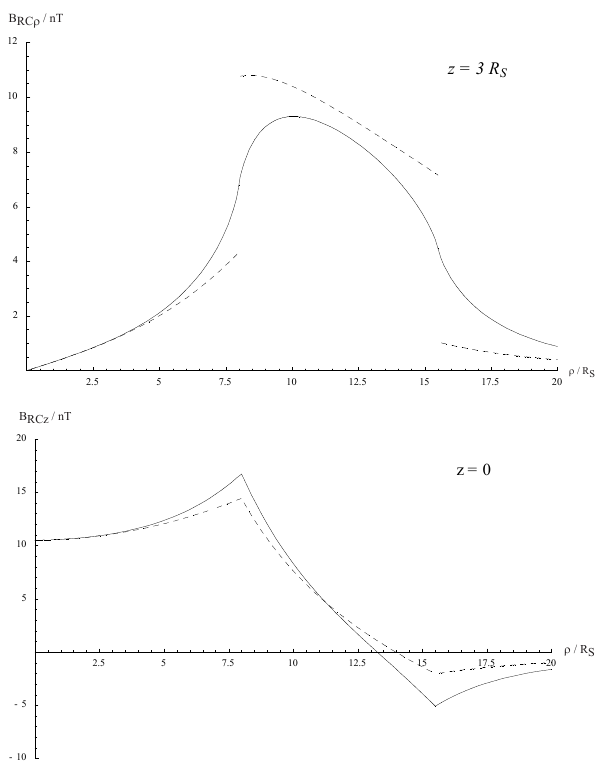
Fig. 1. Plots of the field components produced by the ring current in Saturn’s magnetosphere, as determined from fits to Voyager-1 and -2 magnetic data by Connerney et al. (1983). The solid lines show values determined from numerical evaluation of exact integral ex- pressions (Connerney et al., 1981a), while the dashed lines show analytic approximations, specifically the improved forms given by Edwards et al. (2001). Plot (a) shows the cylindrical radial compo- nent of the ring current field B RCρ at z = 3 R S (the northern edge of the ring current) versus cylindrical radial distance ρ . Plot (b) similarly shows the axial component of the ring current field B RCz at z = 0, also plotted versus ρ over the same